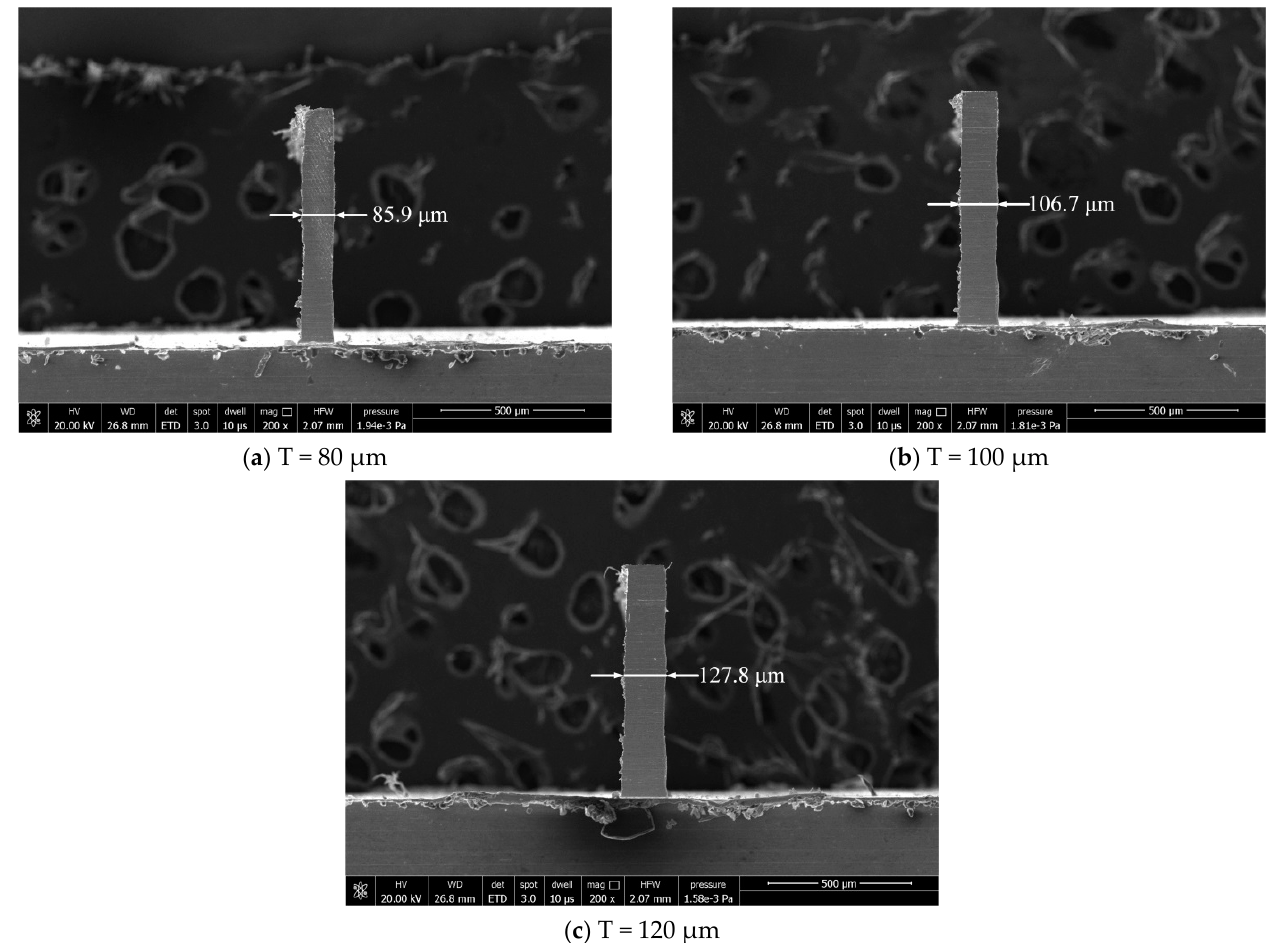
Figure 10. Experiment setup.